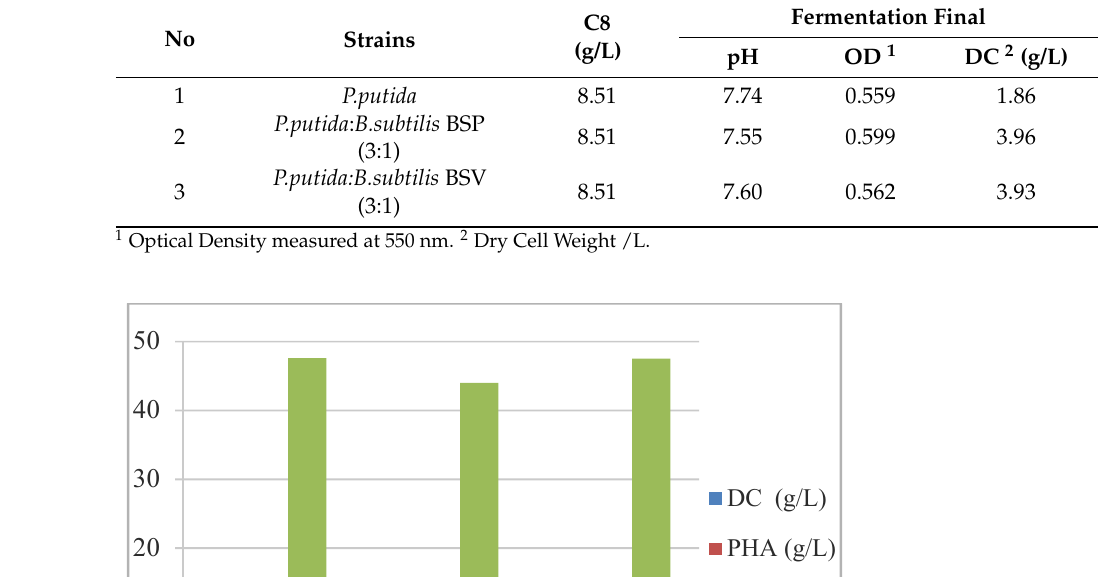
10 of 30 Figure 3. Biomass and mcl ‐ PHA production Reprinted with permission from ref. [65], 2014, Vladu et al., Studia Universitatis. For PHA production, the use of mixed cultures was introduced, improving fermen ‐ tation efficiency [100]. The use of mixed open crops, such as activated sludge [101–103], can contribute to lowering the cost of PHAs, therefore increasing their market potential [104]. For the accumulation of poly ‐ 3 ‐ hydroxyoctanoate (PHO) [68], batch fermentation